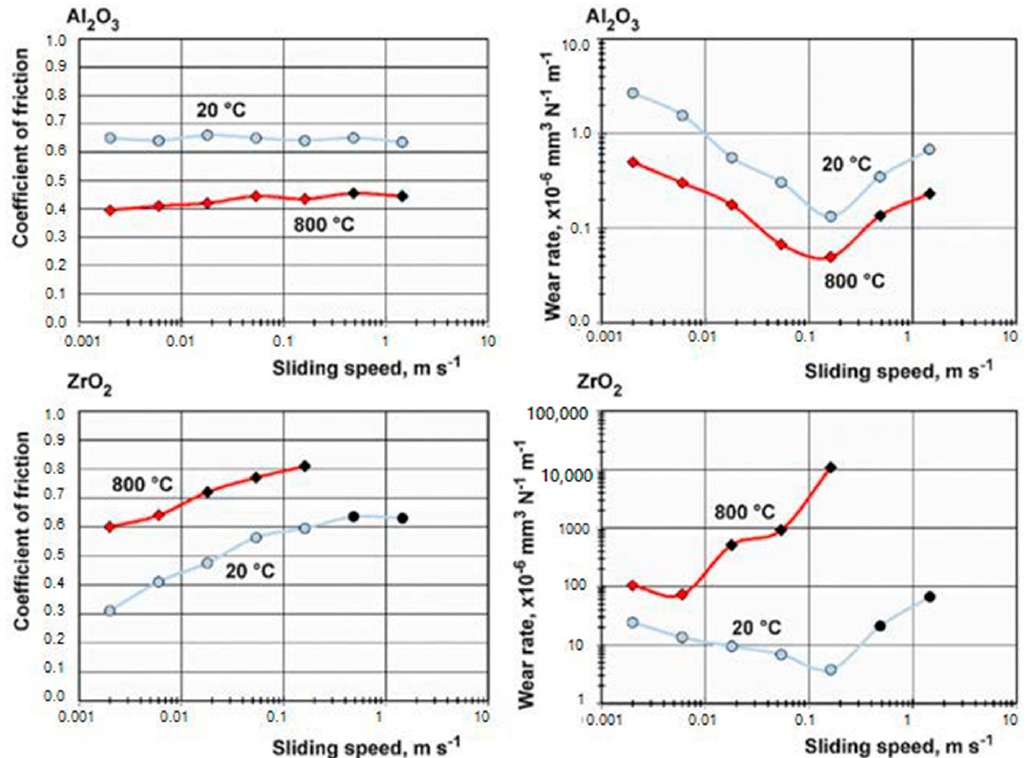
Figure 20. Coe ffi cient of friction and wear rate of the systems 3 µ m thick AlCrN coating deposited on high temperature oxidation resistant stainless steel (EN 1.4835) by means of the arc ion plating technique—Al 2 O 3 and ZrO 2 balls, reprinted from Tribology International , Reference [125], with permission from Elsevier.